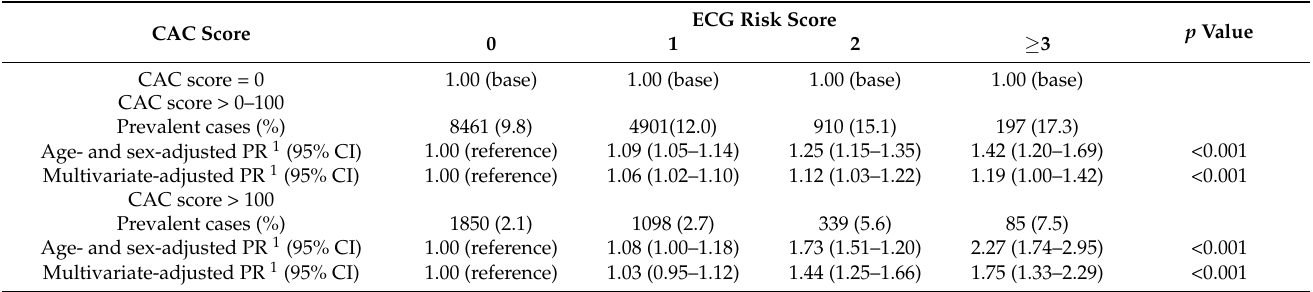
Table 3. Prevalence ratios 1 (95% CI) for CAC score by ECG risk score in 134,802 study